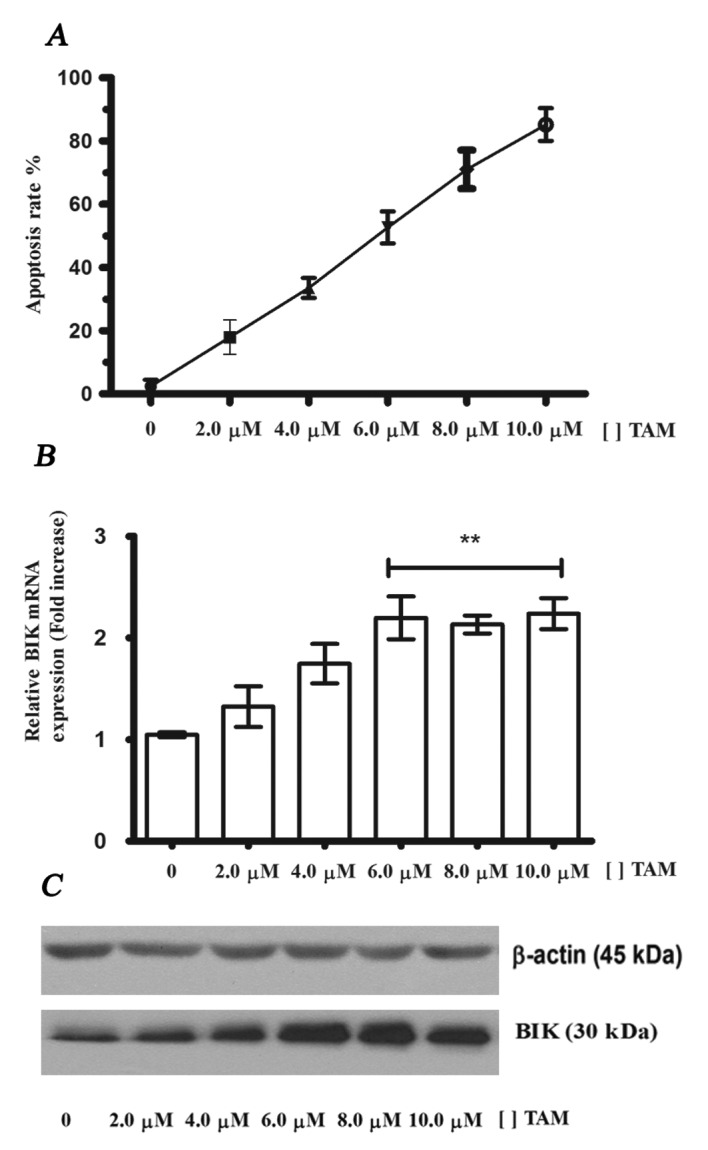
The messenger RNA (mRNA) and protein levels of Bik were increased in MCF-7 cells treated with tamoxifen (TAM). (A) MCF-7 cells were treated with TAM by determining Ec50. (B) MCF-7 cells were treated with TAM for 24 h and subjected to RT-PCR analyses. (C) Cell lysates were prepared and subjected to western blot analyses for Bik and β-actin as a control; one representative of at least three independent experiments with similar results is shown. Each value represents the mean + standard error of the mean (SE) (bars) of three independent experiments. *p<0.05, according to the Student’s t-test.